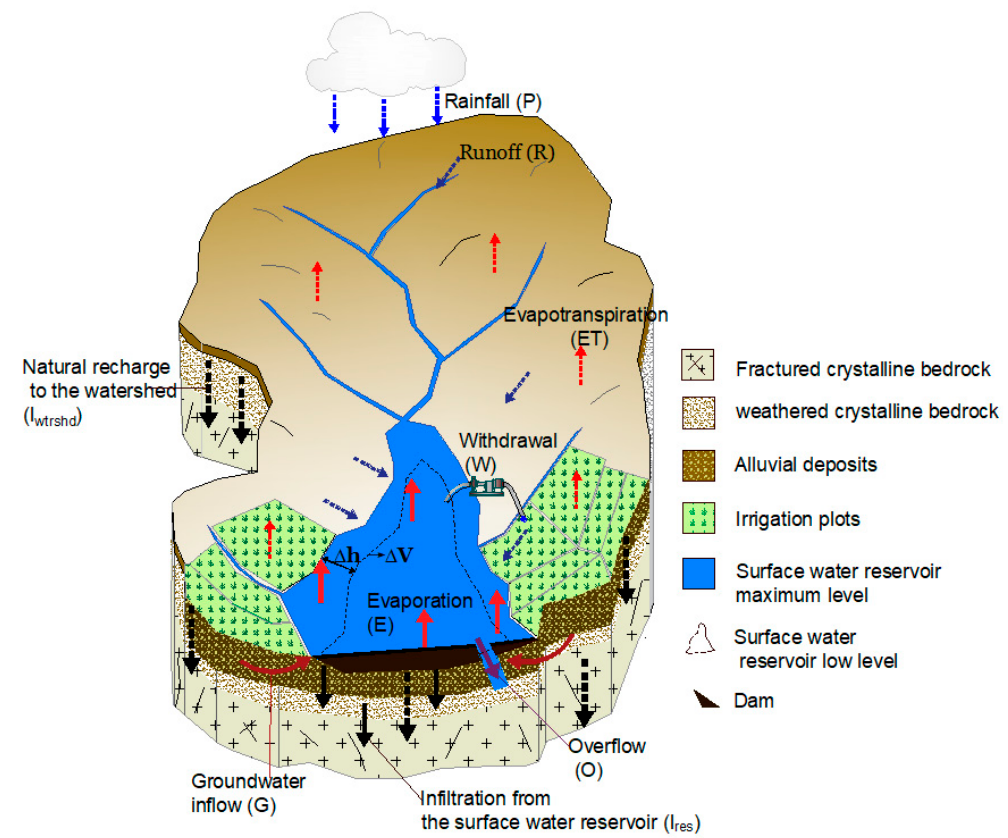
Figure 4. Conceptual model of the hydrological functioning of a Sahelian watershed near a SWR.